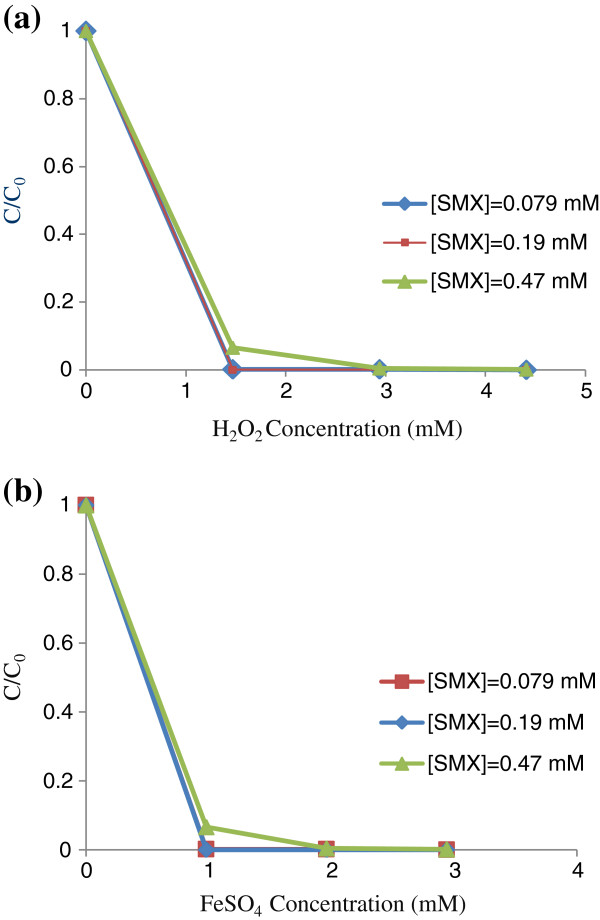
Effect of different concentrations of (a) [H2O2] and (b) [FeSO4] on antibiotic removal in various concentrations: [H2O2]/ [Fe+2] = 1.5:1, [H2O2] = varying, [Fe+2] = varying, pHo= 2.5, retention time= 15 min. The standard deviation of all data points was below 2.